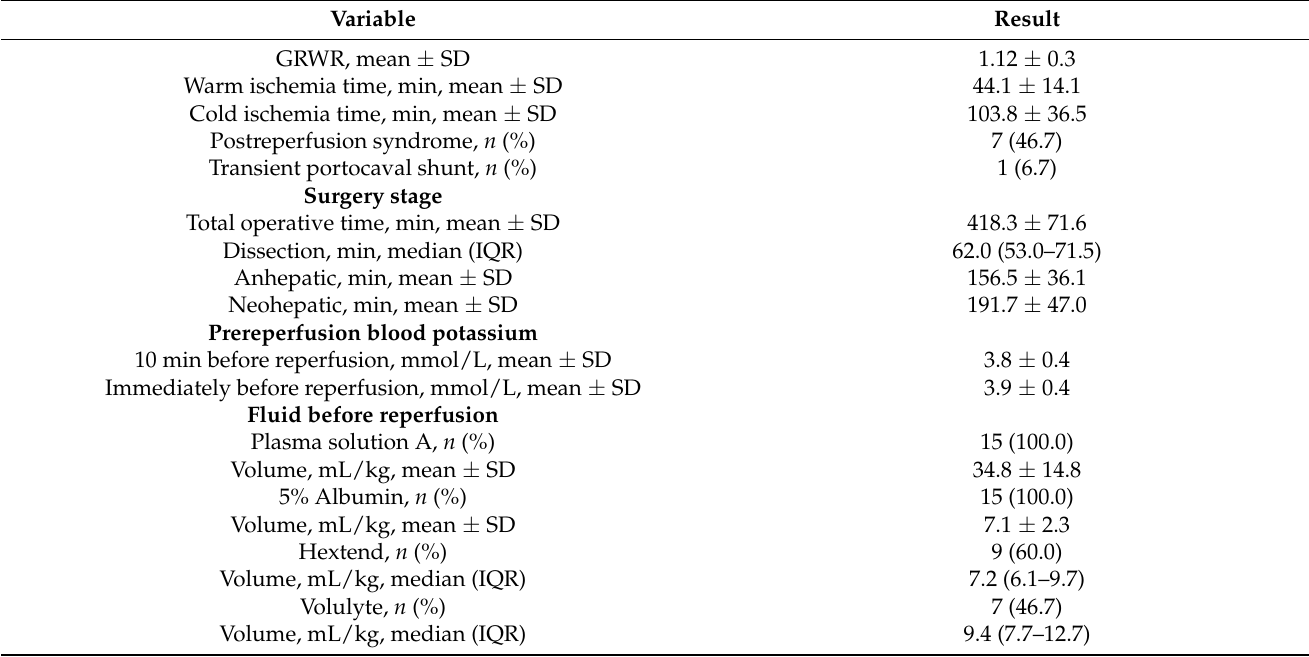
Table 2. Intraoperative variables. Preoperative